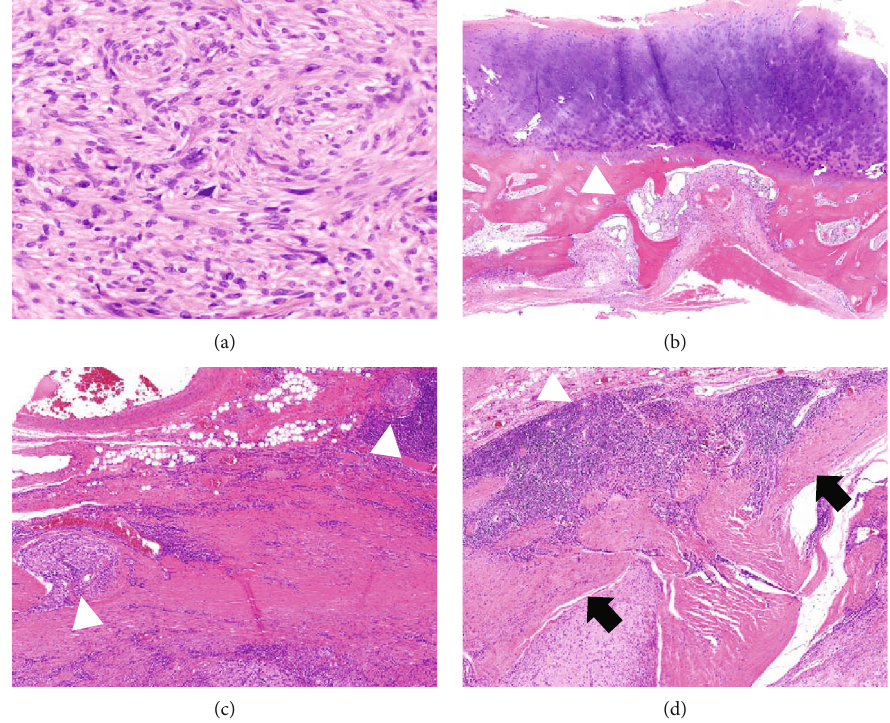
Figure 4: Hematoxylin and eosin staining of the tumor tissue. (a) Proliferation of spindle cells with high cellularity and atypical cells with bizarre nuclei are observed. (b) Tumor cells (white arrowhead) in fi ltrate the subchondral bone under the glenoid cartilage. (c) Tumor cells (white arrowhead) invading surrounding fi broadipose tissue, and (d) lymphoplasmacytic in fi ltration (white arrowhead) surrounding fi brous capsule (black